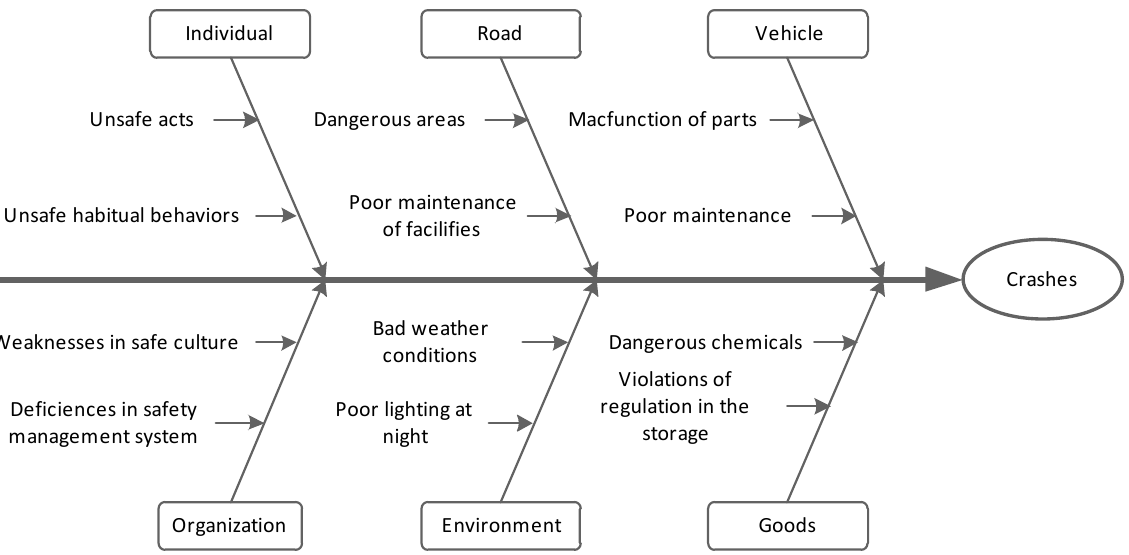
Figure 5. Fishbone diagram of the causal factors contributing to the commercial vehicle accidents.